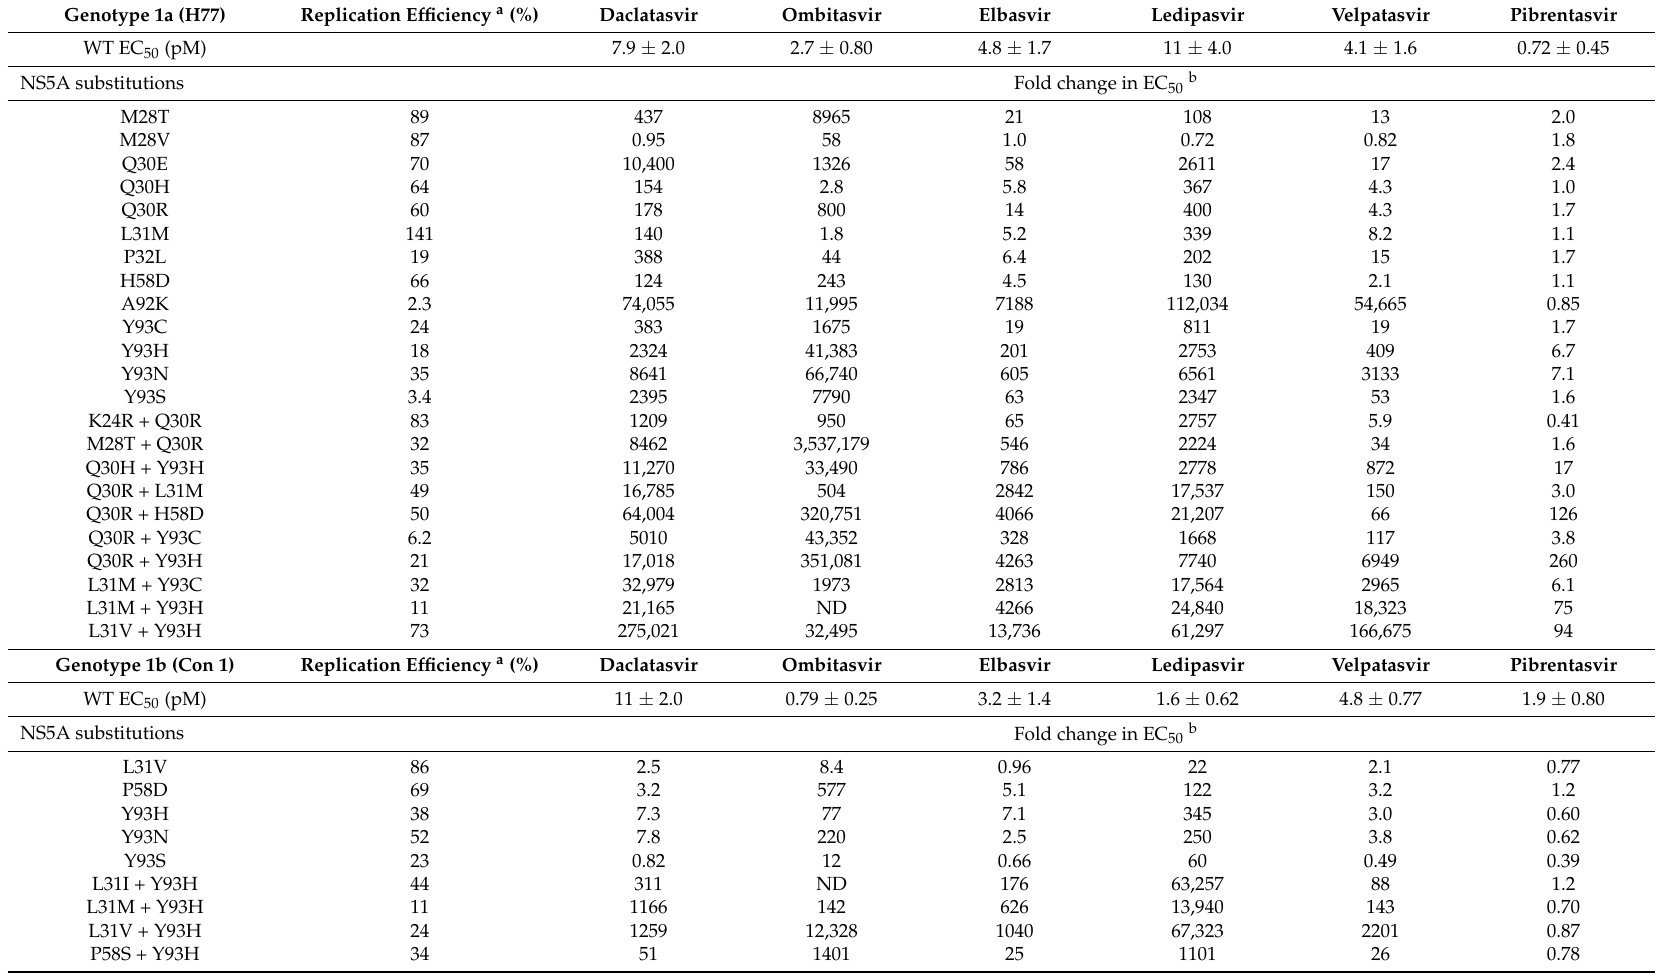
Table 6. Susceptibility of NS5A amino acid substitutions to pibrentasvir and other approved NS5A